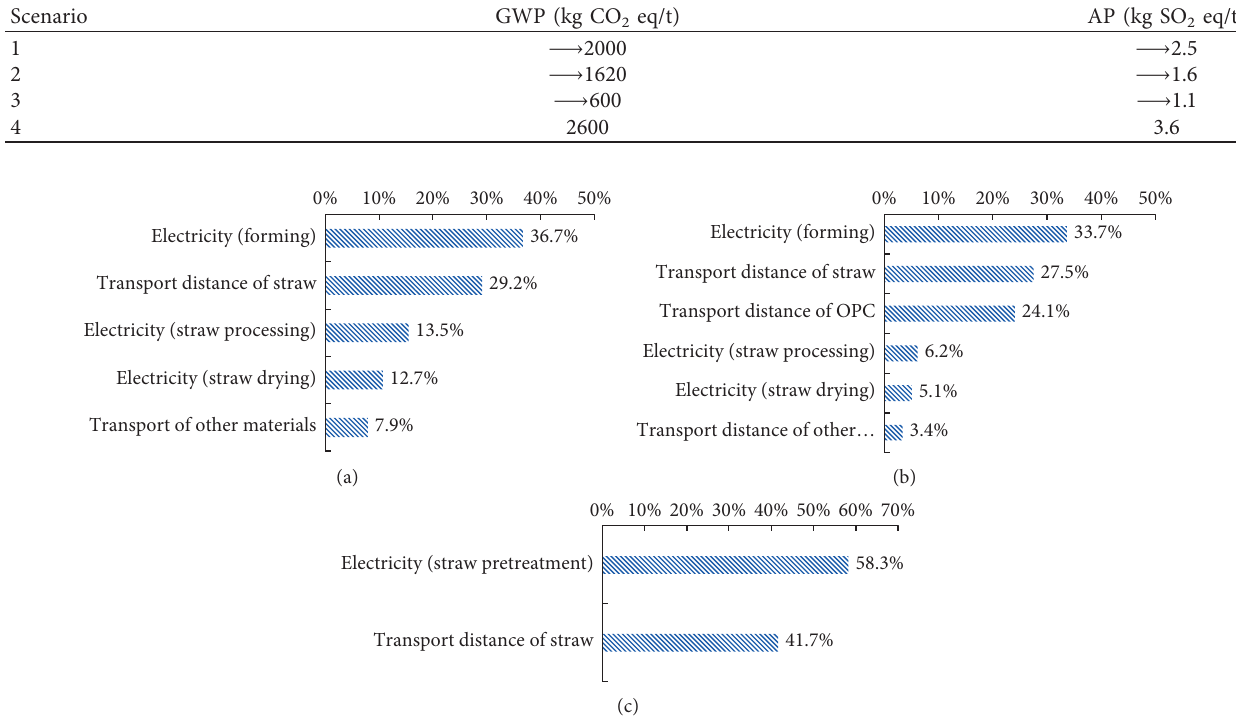
Figure 10: Comparisons of gas emission index under different scenarios: (a) comparisons of CO other gas emission index. Table 12: Comparison of environmental impact trends among different management scenarios.